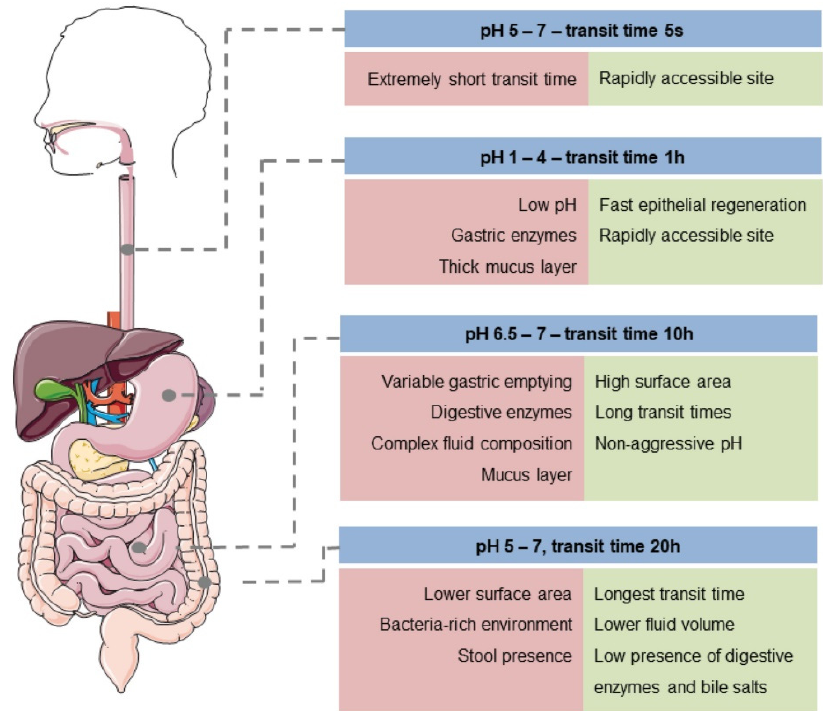
Figure 4. Conditions in the GI tract. Reprinted by permission from John Wiley and Sons [104] Copyright (2021).